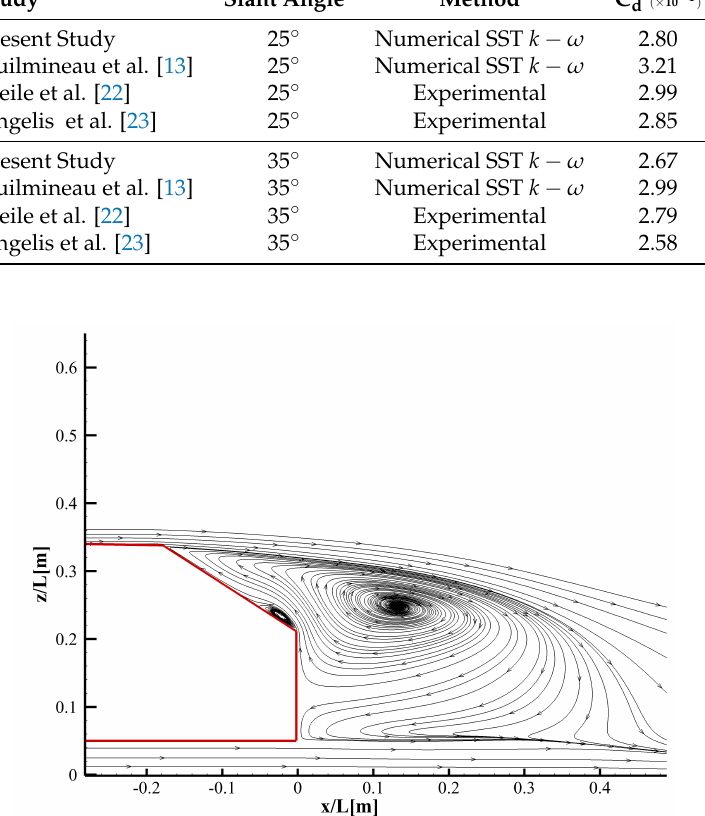
Figure 8. Streamlines in the symmetry plane y = 0 for slant angle 35 ◦ .